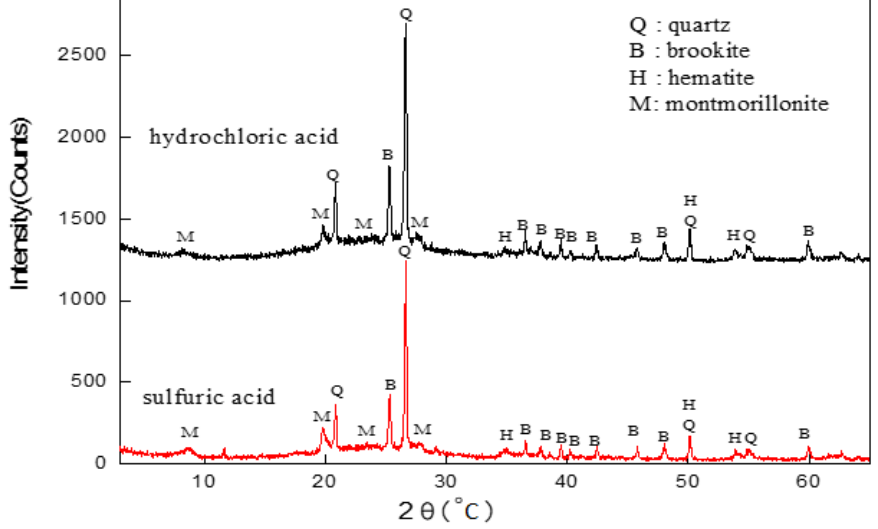
Figure 7. XRD spectra of the filter residue after acid leaching with different acids for 6 h.